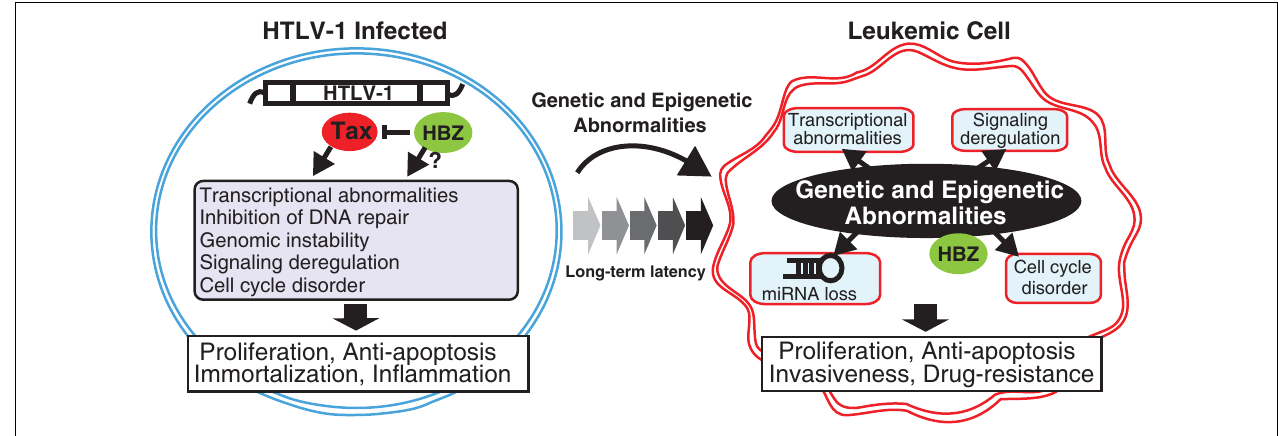
which lead to deregulations of gene expression pattern, cell cycling, signaling activation, and miRNA expression.These molecular changes consequently induce cellular hallmark capabilities of ATL such as chronic proliferation, apoptotic resistance, multiple organ invasion, and drug